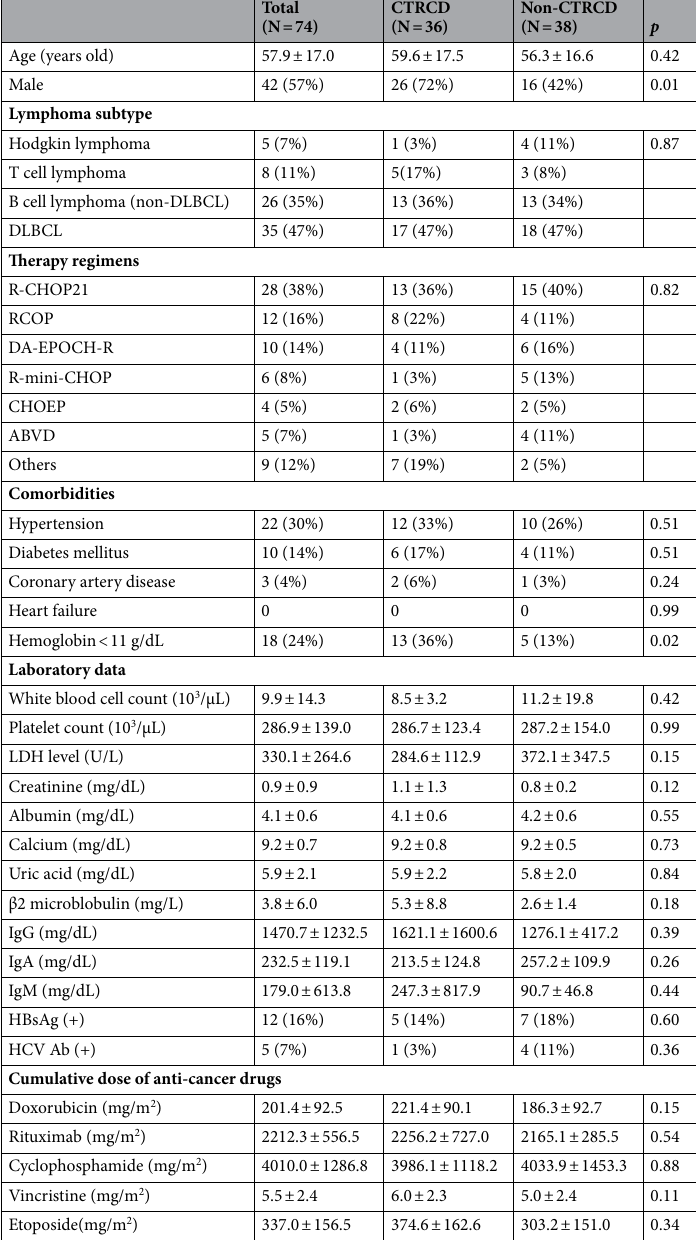
Table 1. Baseline demographic characteristics of the lymphoma patients post anti-cancer therapy with and without left ventricular dysfunction. Chemotherapy regimens: R-CHOP 21: Rituximab, cyclophosphamide, doxorubicin, vincristine and prednisolone; administered every 21 days. R-COP: Rituximab, cyclophosphamide, vincristine and prednisolone. DA-EROCH-R: dose-adjusted etoposide, prednisone, vincristine, cyclophosphamide, doxorubicin, and rituximab. R-mini-CHOP: Rituximab, low dose of cyclophosphamide, vincristine and prednisolone. CHOEP: cyclophosphamide, doxorubicin, vincristine, etoposide and prednisolone. ABVD: Doxorubicin, bleomycin, vinblastine and dacarbazine. Data are expressed as mean ± SD or number (%). CTRCD indicates cancer therapy-related cardiac dysfunction; DLBCL, diffused large B cell lymphoma; HBsAg, hepatitis B surface antigen; HCV Ab, hepatitis C viral antibody; Ig, immunoglobulin; LDH, lactate de and LV, left